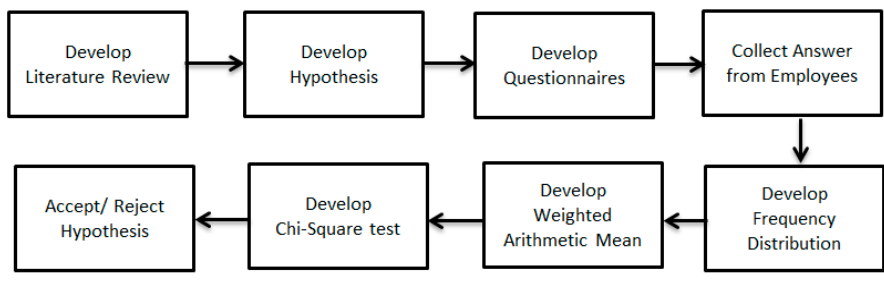
Figure 9. Proposed model for research.